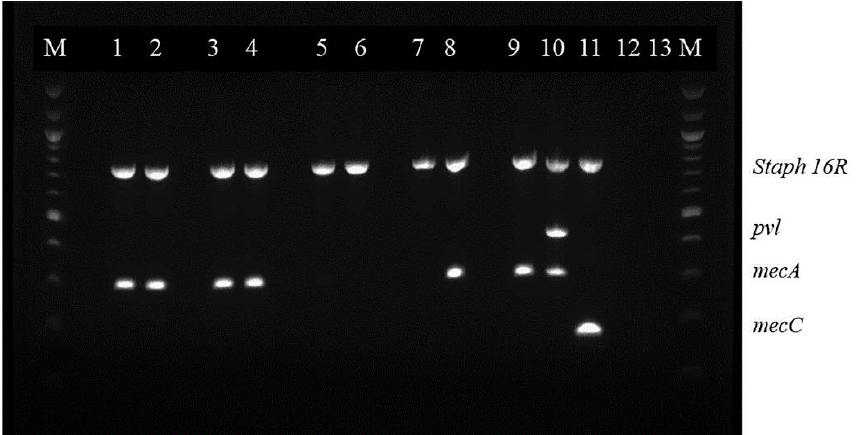
Figure 1. Multiplex PCR for coagulase positive staphylococci. M — Promega ® 100 BP DNA Ladder; Lanes 1 – 9 tested isolates; 10, MRSA (ATCC 1756) positive control for Staph 16R , pvl and mecA ; 11, MRSA (ATCC 2312) positive control for Staph 16R and mecC ; 12 – 13, negative controls.